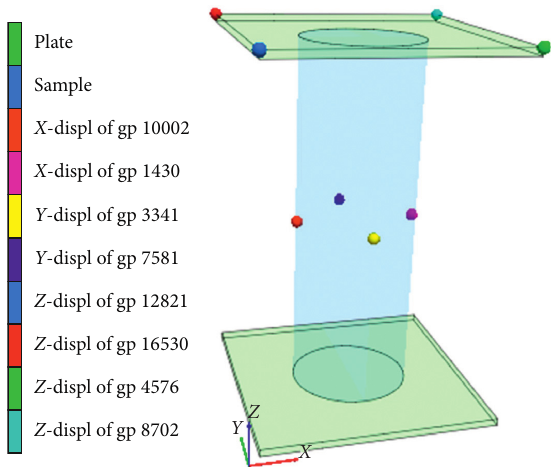
Figure 2: Grid points monitored in the simulation